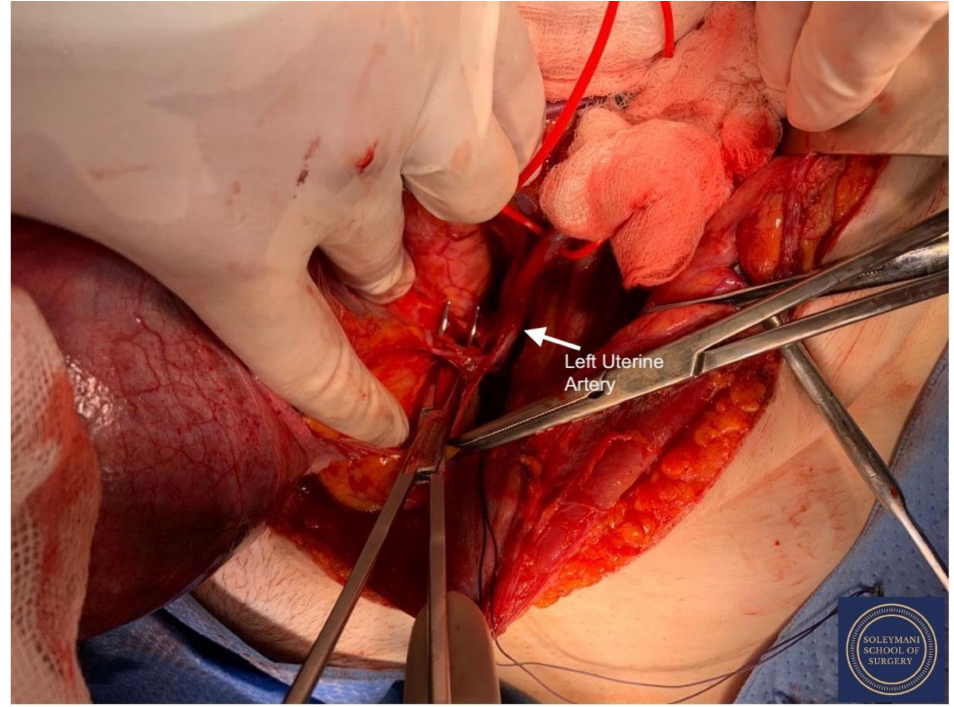
Figure 10. Exposure of the left uterine artery at origin from the internal iliac artery prior to